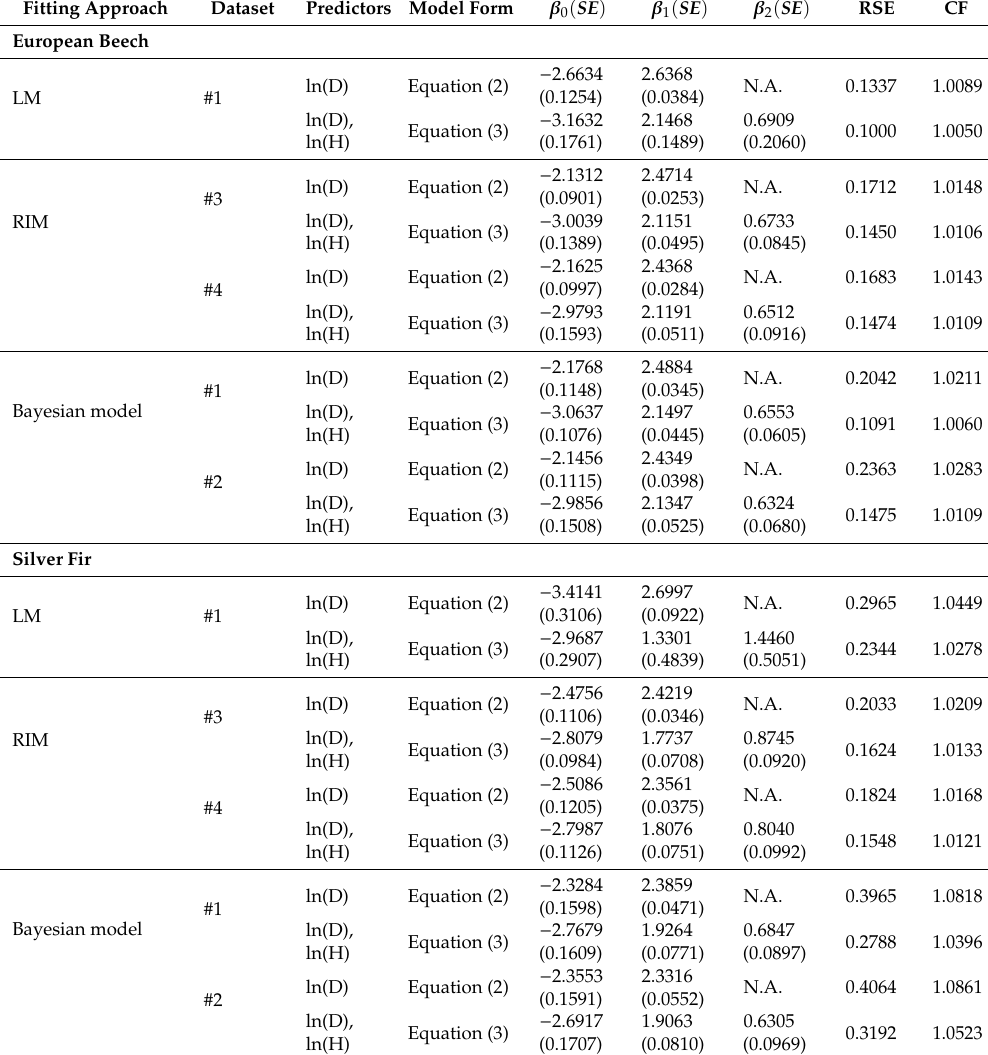
Table 5. The parameters of allometric biomass models predicting tree aboveground biomass (AGB), by fitting approach and predictor combination. Standard errors of model parameters are presented in parenthesis. RSE is the residual standard error; CF is the correction factor and was calculated as in Equations (4) or (5); LM is the linear regression model on log-transformed data (Section 2.2.1); RIM is the random intercept model (Section 2.2.2); ln(D) is the logarithm of diameter at breast height; ln(H) is the logarithm of tree